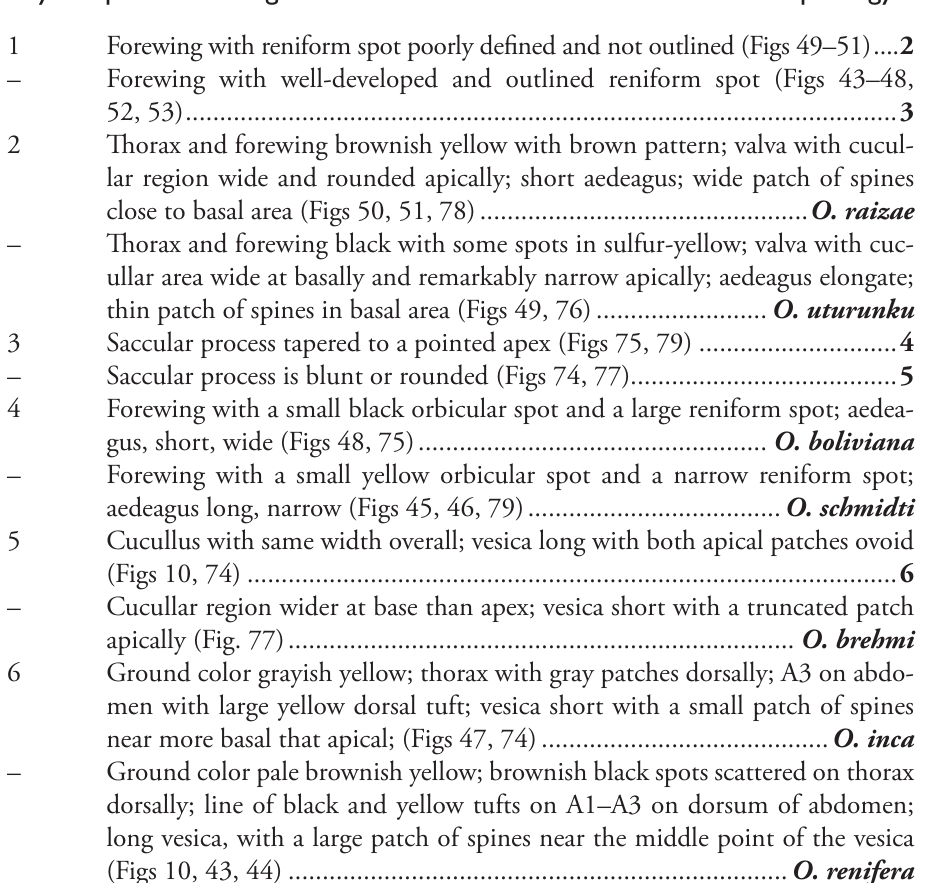
Ground color pale brownish yellow; brownish black spots scattered on thorax dorsally; line of black and yellow tufts on A1–A3 on dorsum of abdomen; long vesica, with a large patch of spines near the middle point of the